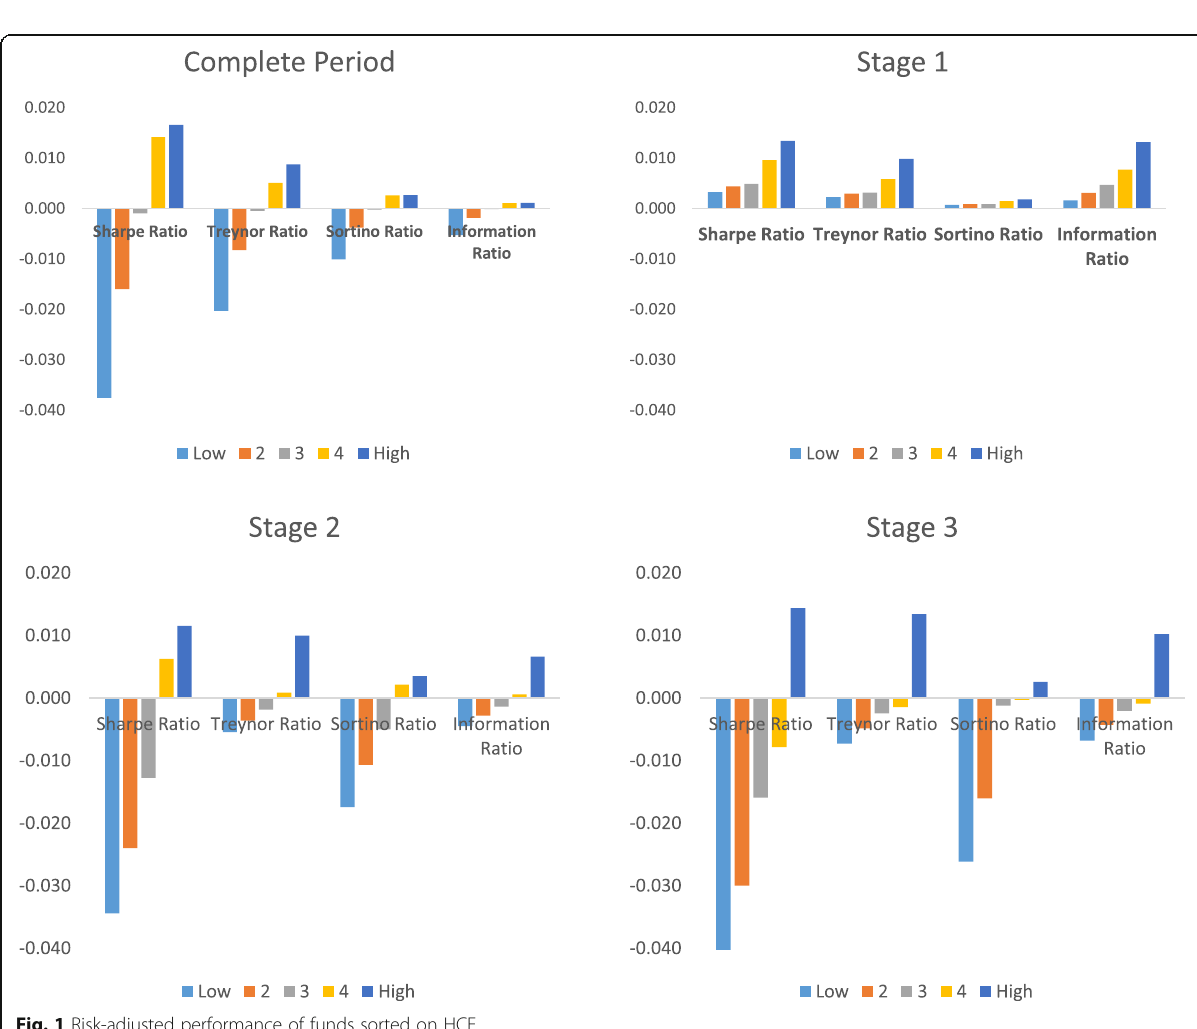
Fig. 1 Risk-adjusted performance of funds sorted on